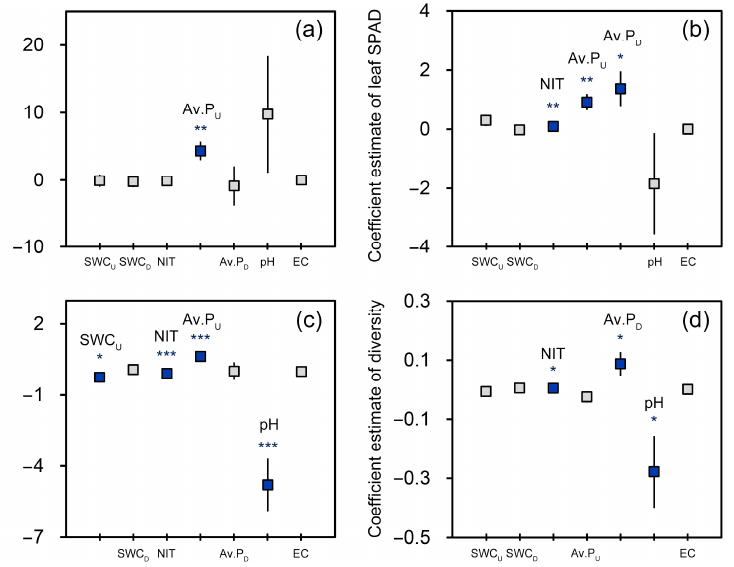
Figure 5. Relationship between growth indices of P. australis and soil properties. The coefficient estimate of plant height ( a , AIC = 475.2, R 2 = 0.56), leaf SPAD value ( b , AIC = 328.2, R 2 = 0.69), biomass ( c , AIC = 285.8, R 2 = 0.63) and vegetation diversity ( d , AIC = 81.79, R 2 = 0.64) effect sizes with ± 95% confidence intervals, while accounting for the random effect of soil properties tested using the linear mixed-effects model. Mean coefficient estimates are significant if their 95% confidence intervals did not contain 0. Negative or positive trend values indicate temporal decrease or increase, respectively. *, p < 0.05. **, p < 0.01. ***, p < 0.001. SWC U , soil water content in the upper layer (0–40 cm). SWC D , soil water content in the deeper layer (40–100 cm). NIT, soil NO 3 − contents. Av. P U ,